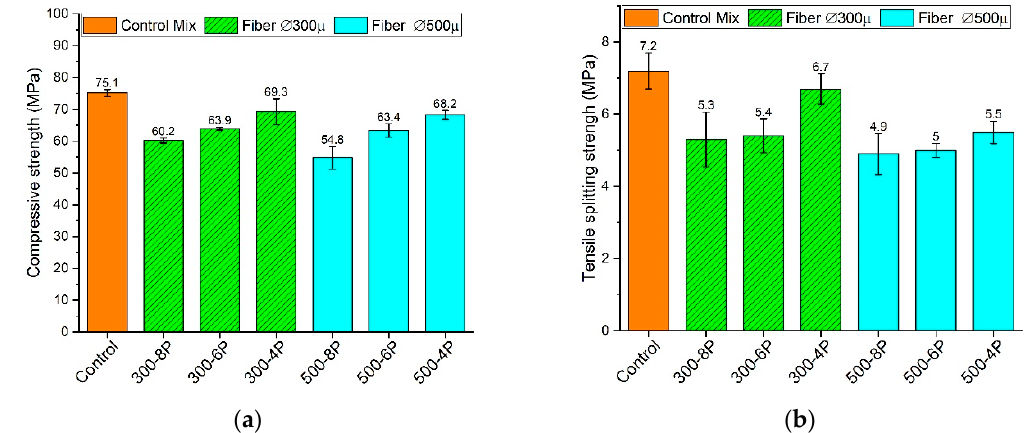
Figure 4. Compressive strength ( a ) and splitting tensile strength ( b ) of the bamboo fiber-reinforced mortar mixtures. Table 3. Physical and mechanical properties of the Bamboo Fiber-reinforced mortar mixtures.